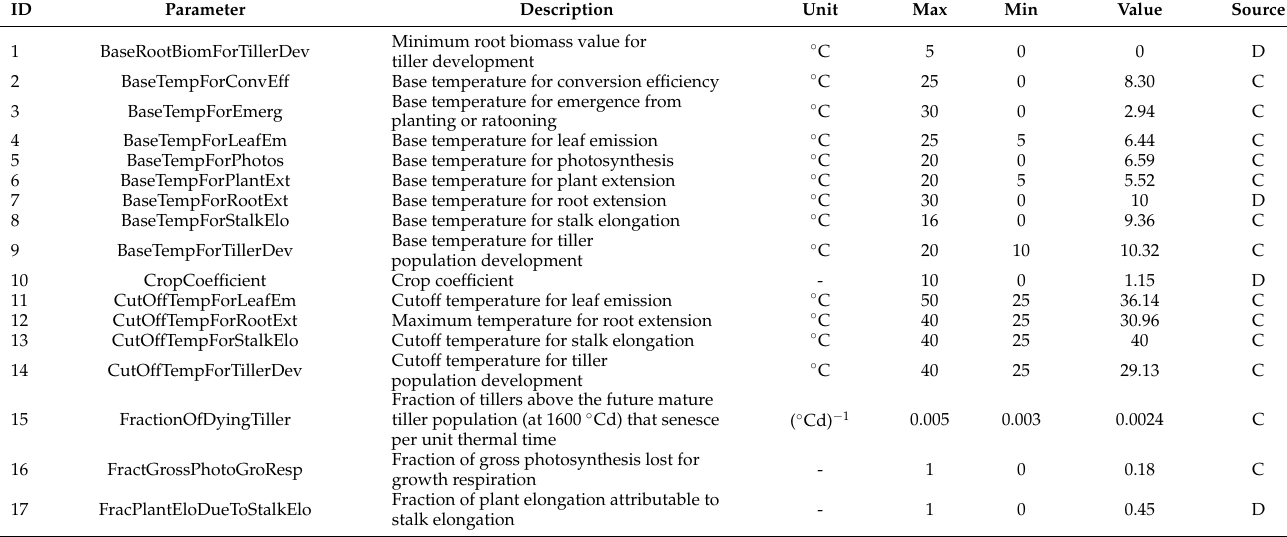
Table 1. Arungro parameter list. Parameter values marked with “D” were set to defaults, while the remaining ones (“C”) were calibrated within ranges reported in model documentation. BO = Bologna; CT = Catania.